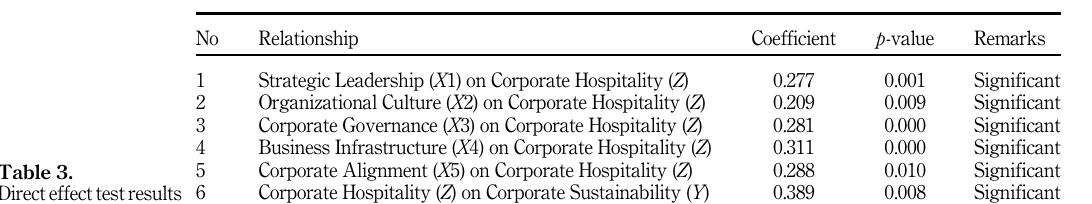
Table 2. Linearity assumption